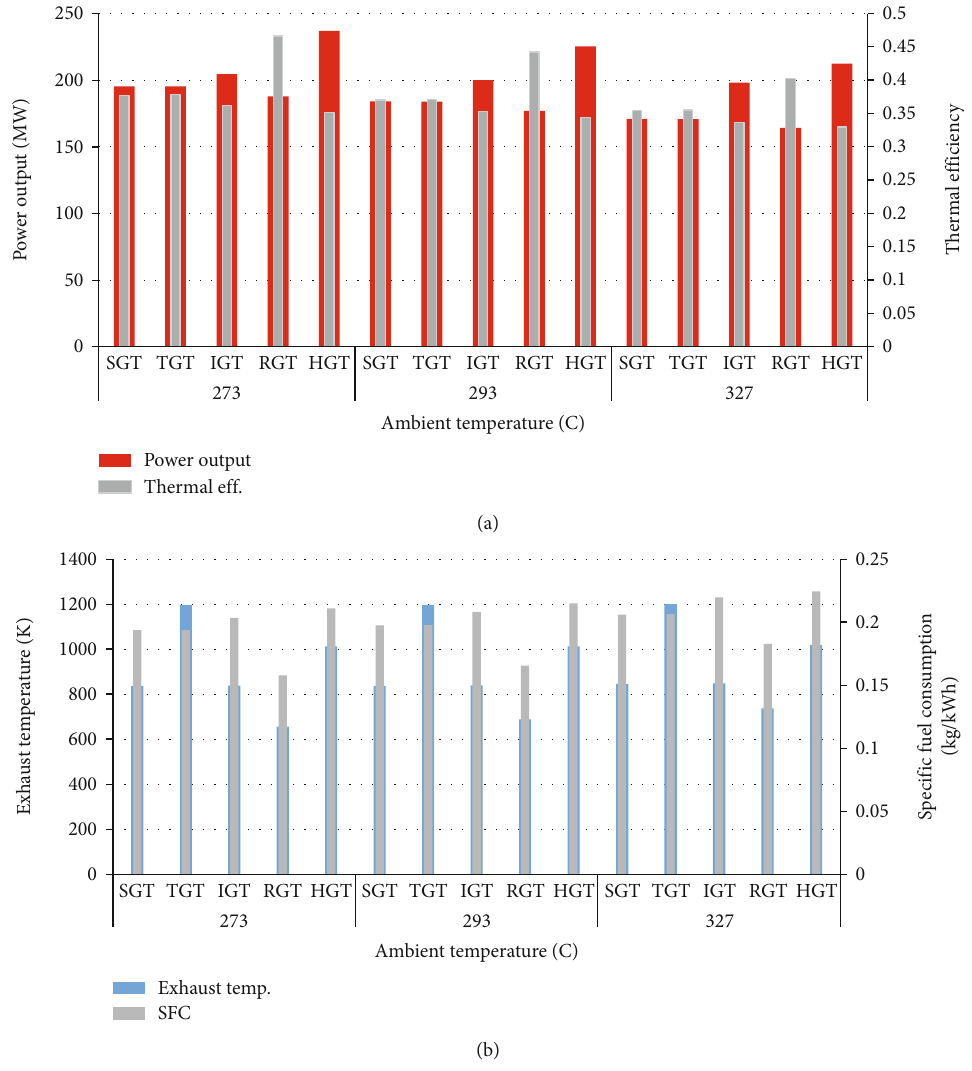
Figure 7: The impact of ambient temperature ( ° C) on the performance of the gas-turbine.